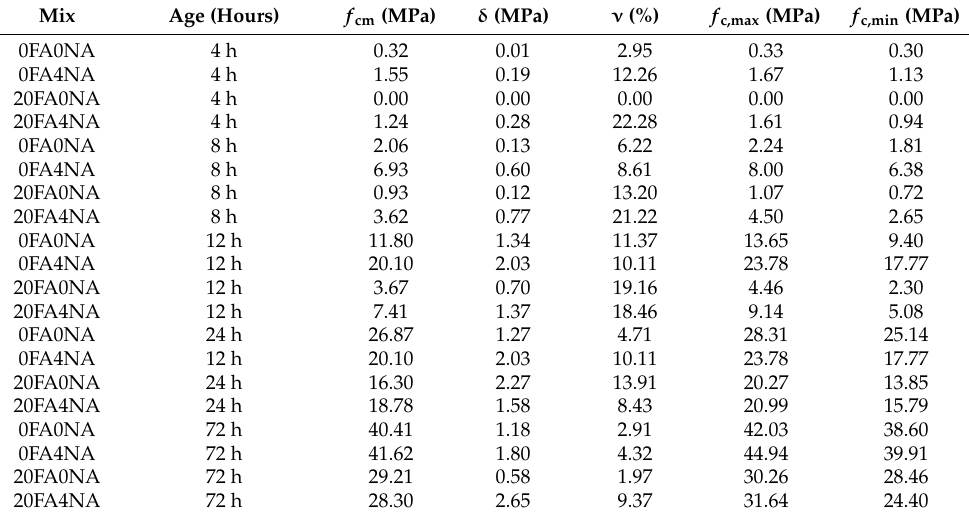
Table 1. Compressive strength f cm of concretes for each curing time.